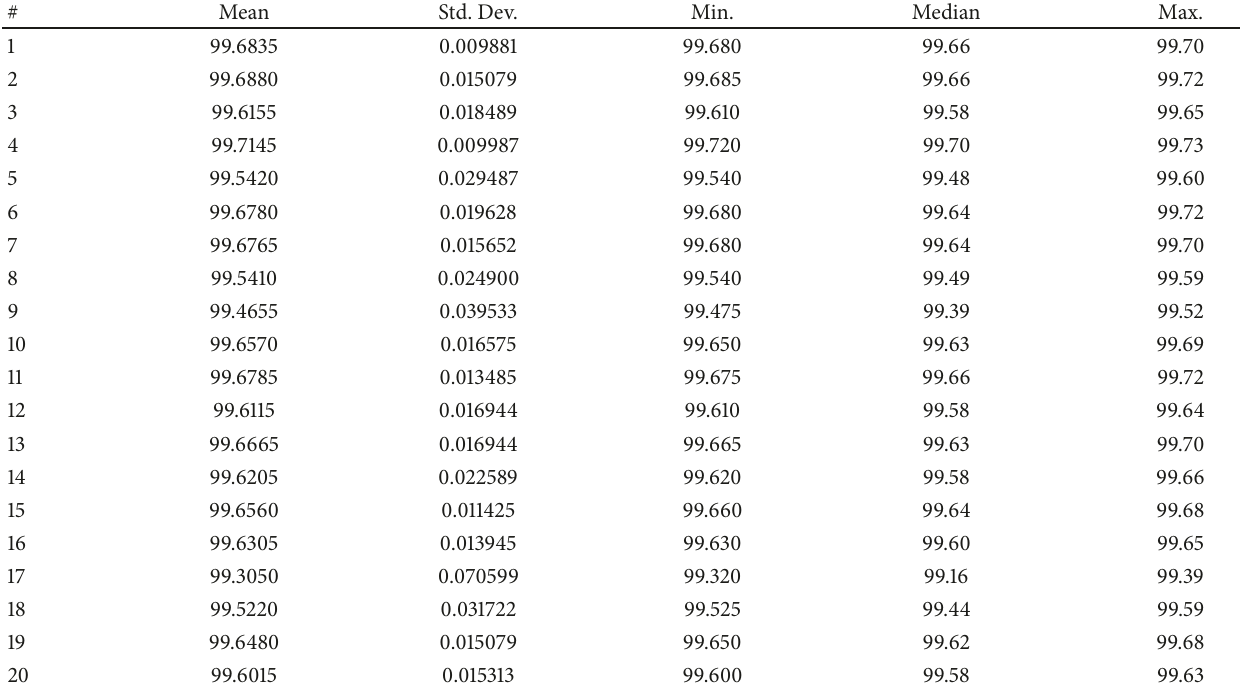
Table 5: Summary of accuracies of the best 20 GE individuals after full training in EMNIST